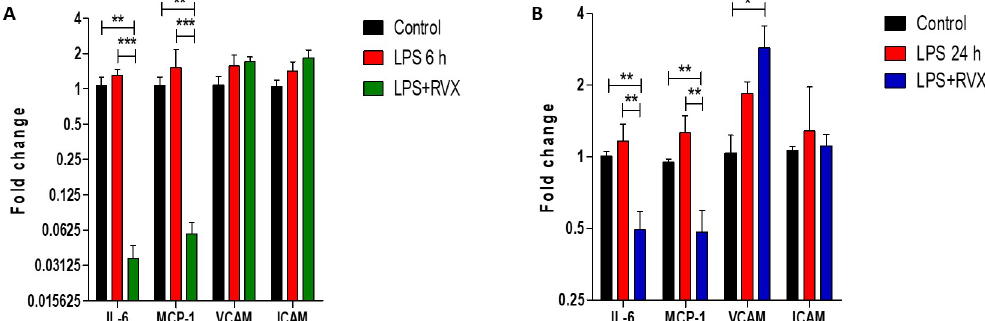
Fig 2. Role of RVX pre-treatment on LPS induced proinflammatory and proadhesive mediator’s gene expression in rat aorta. Comparisons of relative IL-6, MCP-1, VCAM-1 and ICAM-1 gene expression levels normalized to GAPDH in the rat aorta obtained from RVX- or non-treated LPS rats and non-treated control rats 6 hours (A) and 24 hours (B) post LPS exposure. � P < 0.05, �� P < 0.01 and ��� P < 0.001 indicates values significantly different (Student’s t-test) vs LPS. Values are expressed as the mean ± SEM (n =